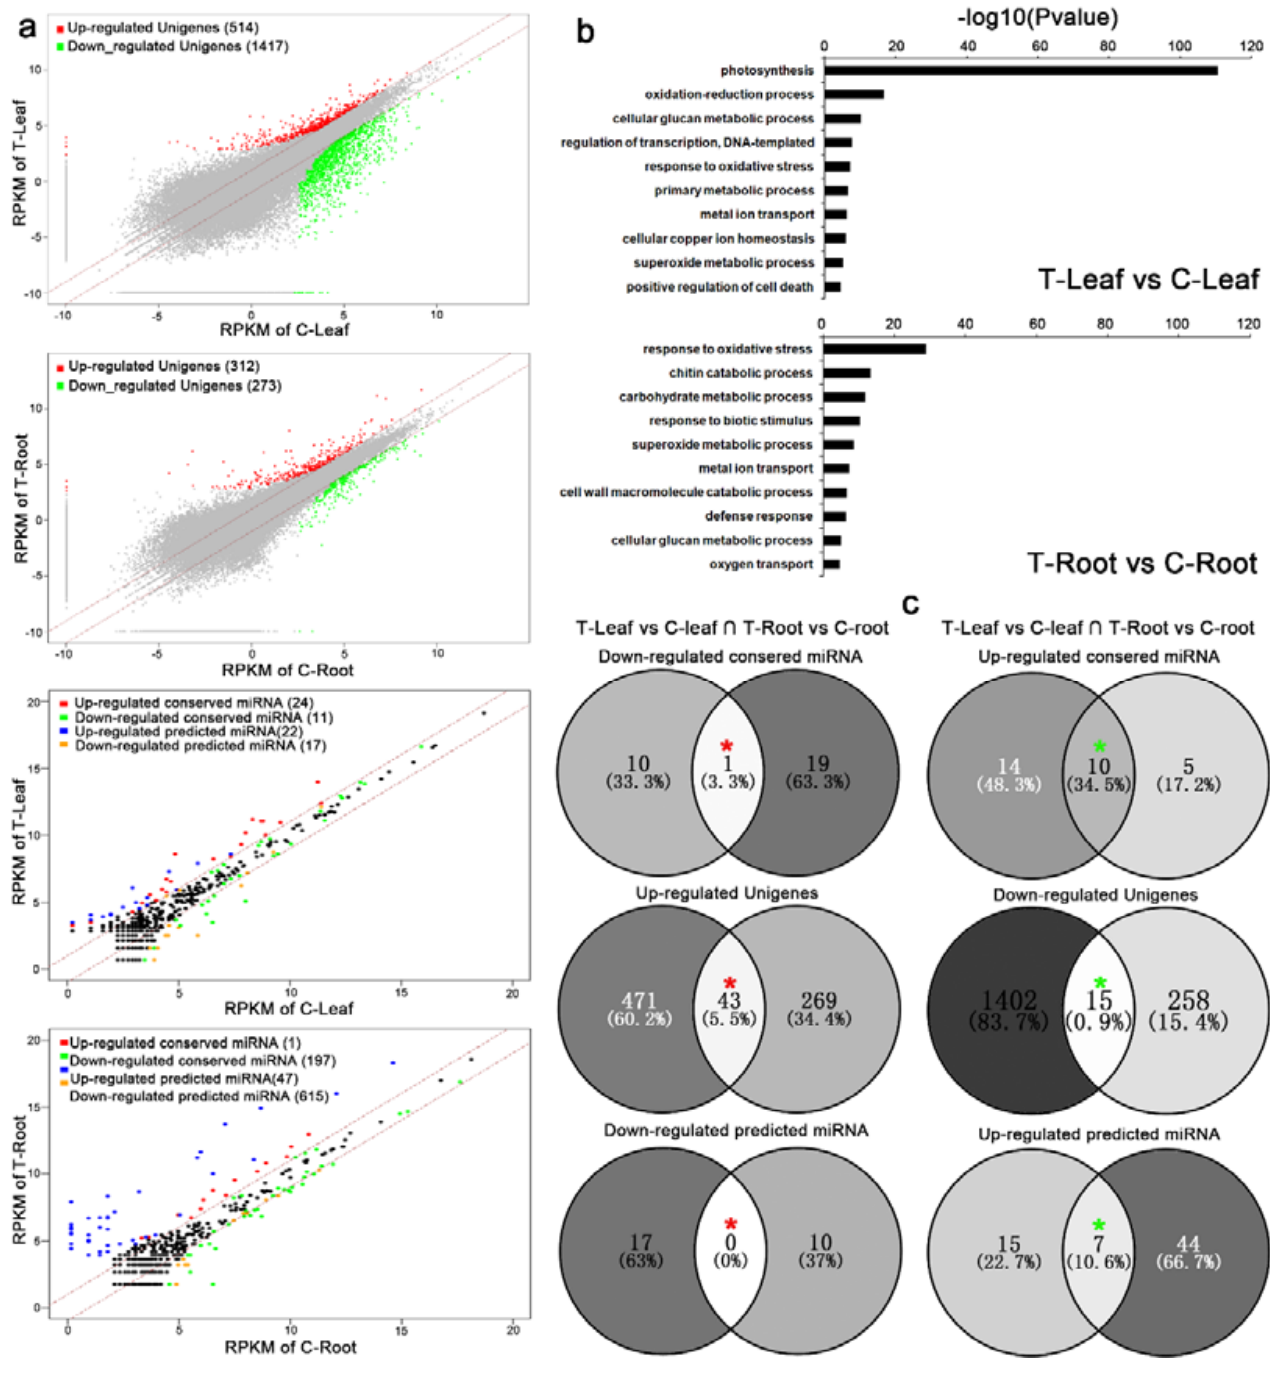
Figure 6. Identification and annotation of differentially expressed unigenes and miRNAs from leaves and roots with or without Cd treatment in Brassica juncea : ( a ) Changes of transcript abundance levels in leaves and roots with or without Cd 2+ treatment. ( b ) Functional annotation of differentially expressed unigenes in leaves and roots with or without Cd treatment. ( c ) The number of identified up- and down-regulated unigenes, and the known and novel miRNAs in leaves and roots of Brassica juncea , the red * sign means the numbers of intersection in leaf and root with down-regulated miRNA and negative(up)-regulated unigenes; the green * sign means the numbers of intersection in leaf and root with up-regulated miRNA and negative(down)-regulated unigenes.